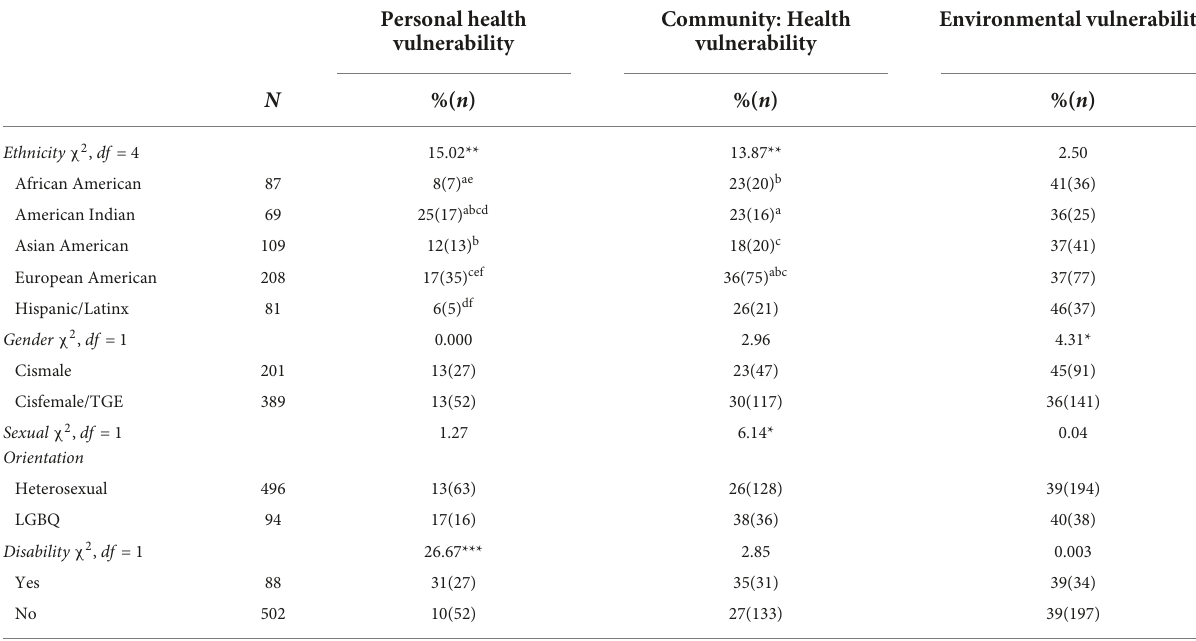
TABLE 3 Chi-square of ethnicity, gender, sexual orientation, disability status, and COVID-19 risk.